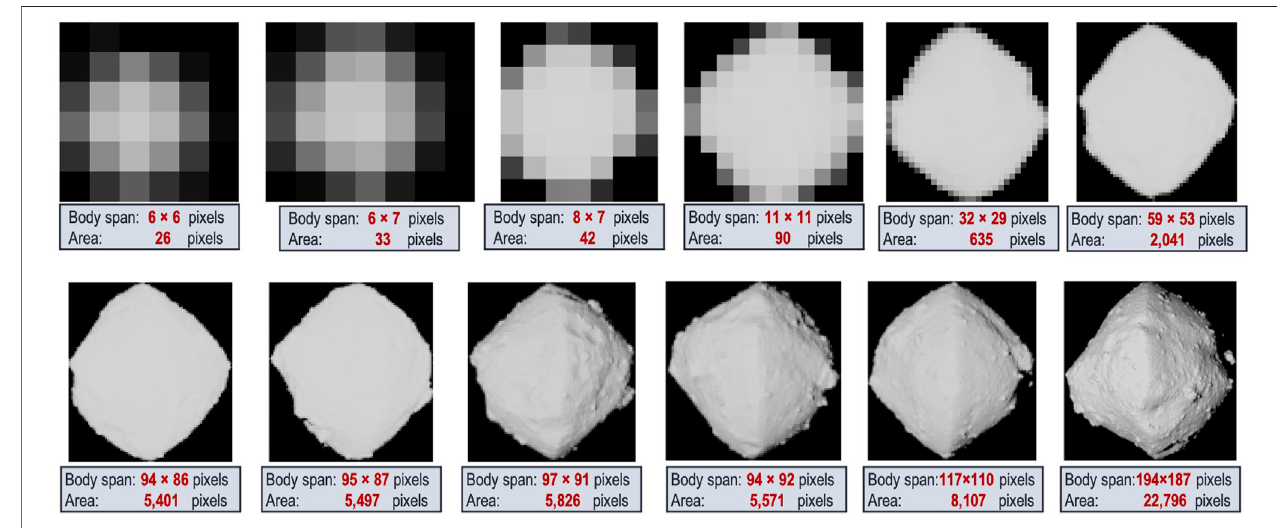
FIGURE 9 | First image in image sets 1 – 12 of the